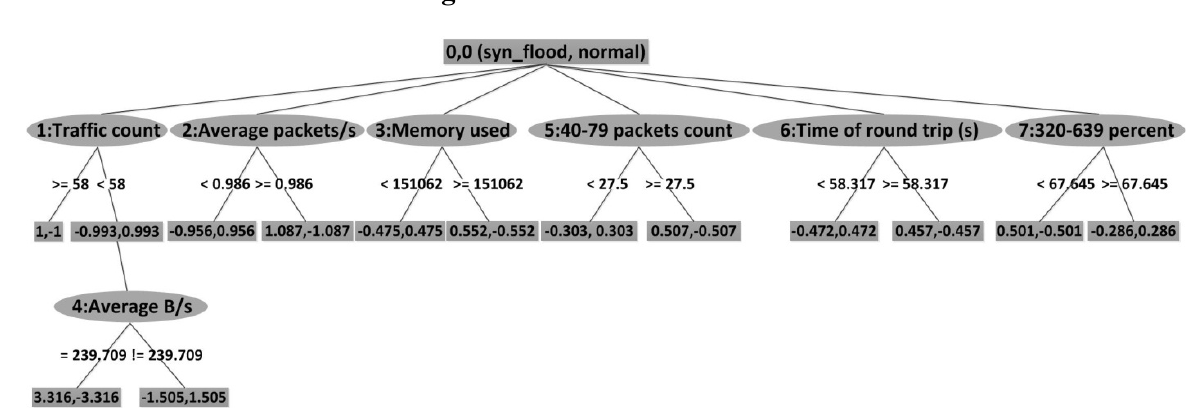
Figure 6. A result of LADTree.